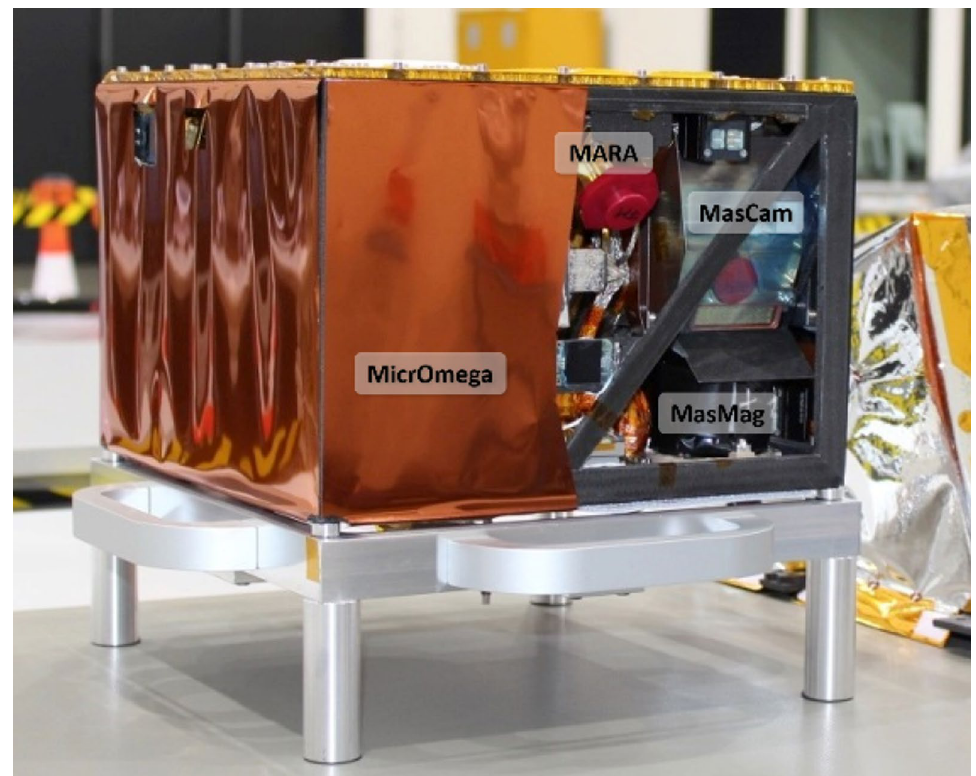
Fig. 1 Photo of the MASCOT lander with its scientific instruments labeled. Note that MARA and MasCam have overlapping field of views